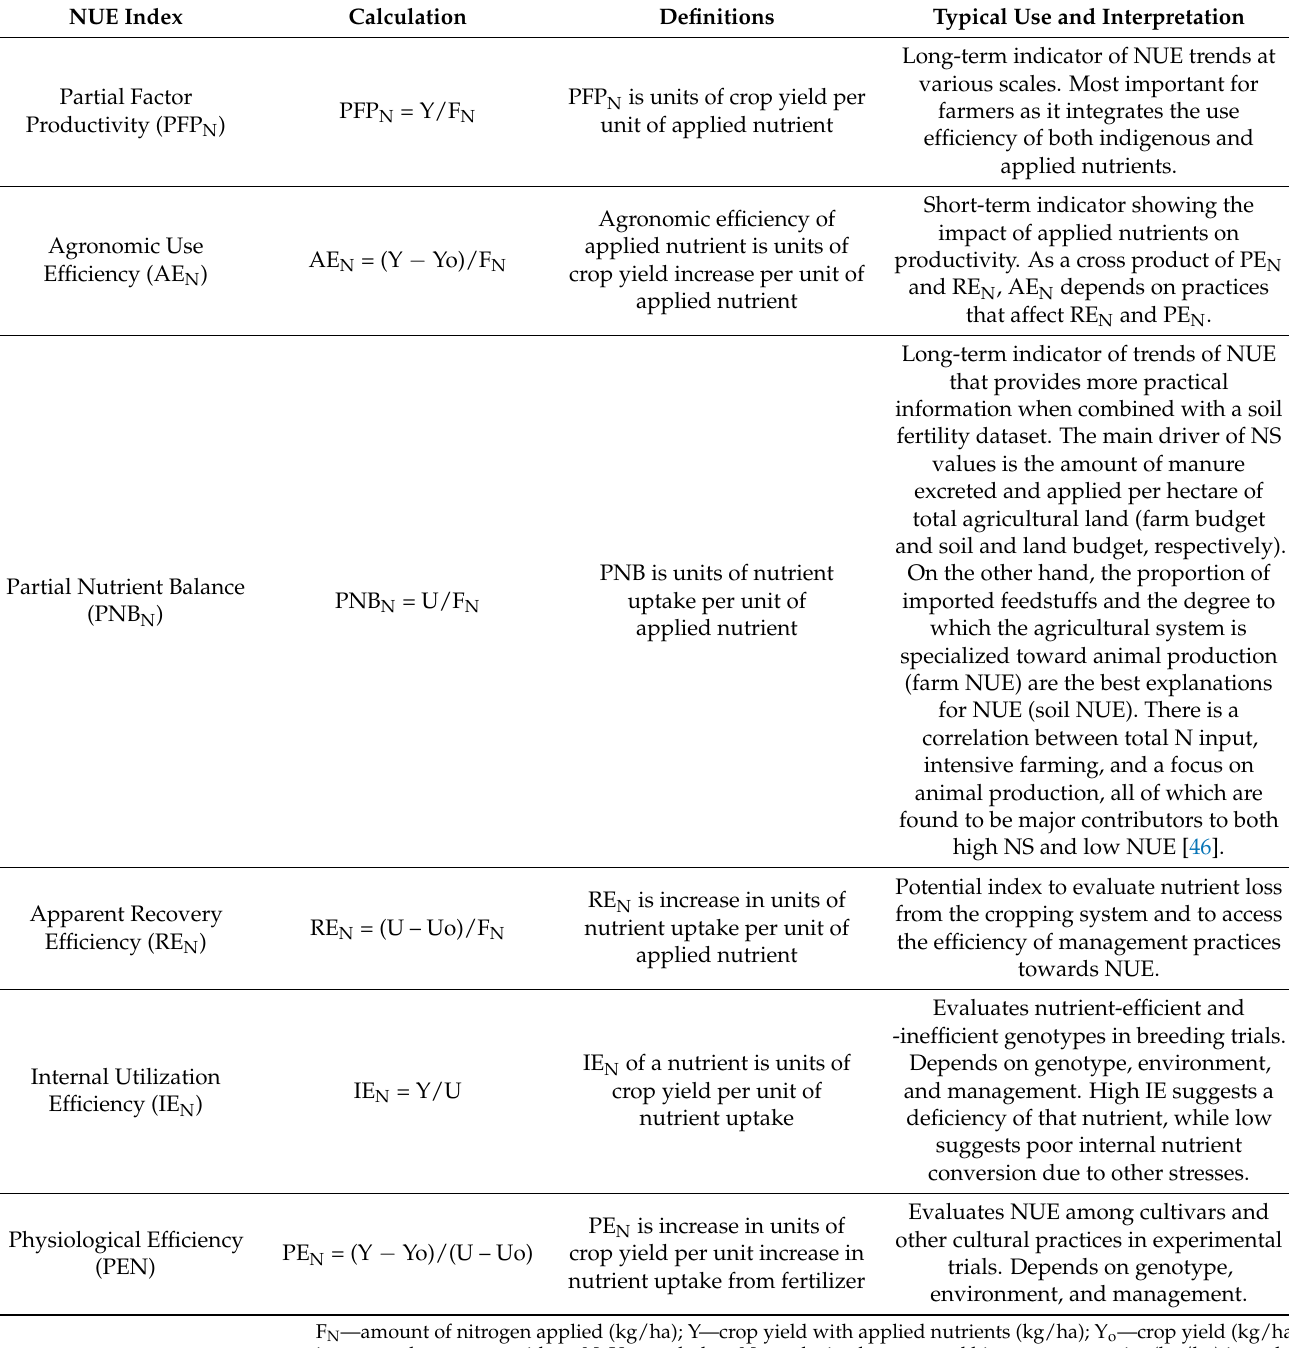
Table 2. Different commonly used indices of nitrogen use efficiency, their assessment using the difference method, and their basic